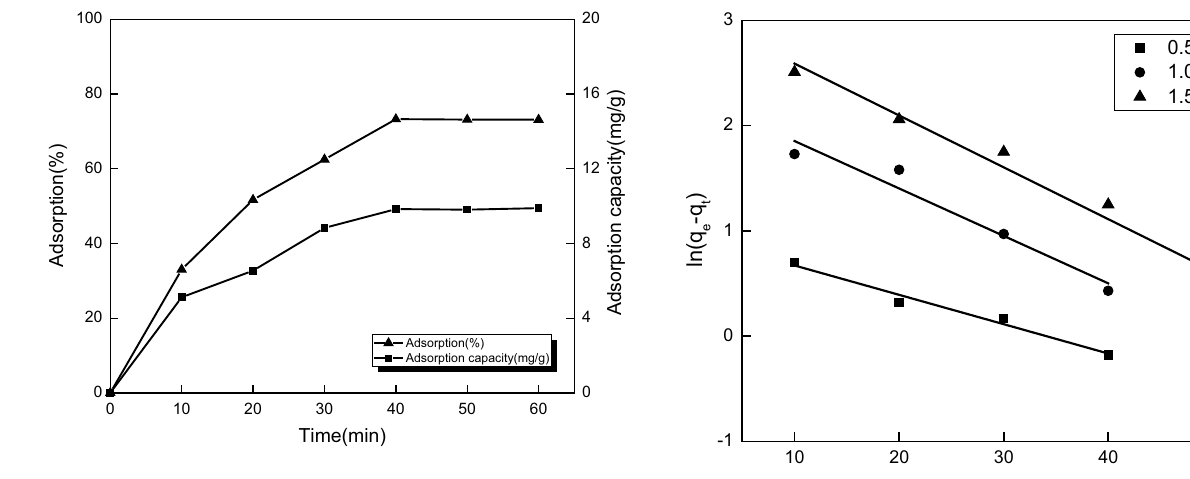
Fig. 9 Effect of contact time on cadmium adsorption; pH = 5.0, C m(SBA-15) = 0.10 g, Cd 2 + = 1.0 mg/mL, T = 25 °C